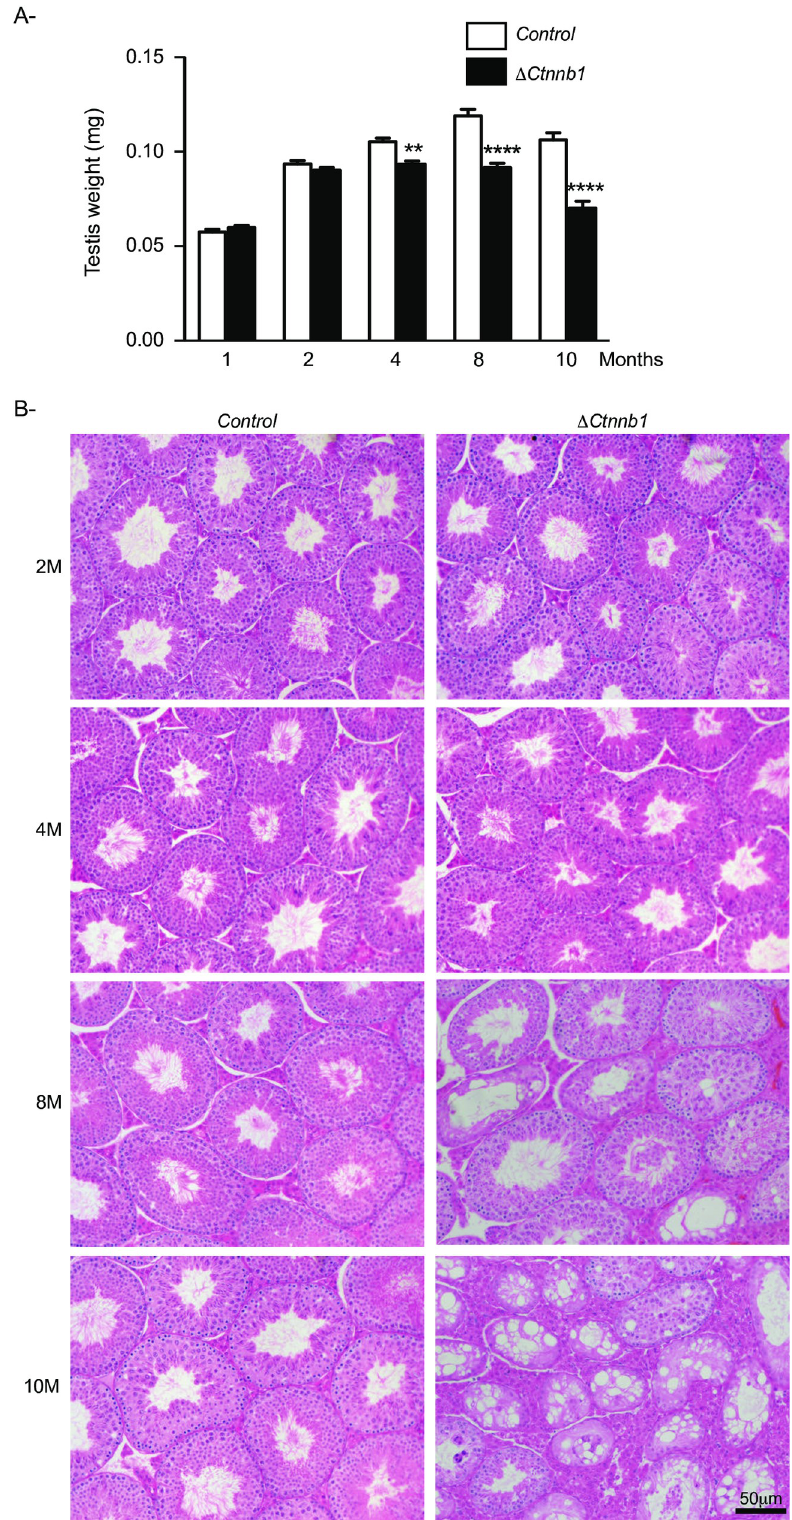
Fig 2. Loss of spermatogenesis in the seminiferous tubules of Δ Ctnnb1 mice. A) Time course analysis of testicular weight comparing Δ Ctnnb1 to control mice at the indicated ages. Sample numbers analyzed varied by age